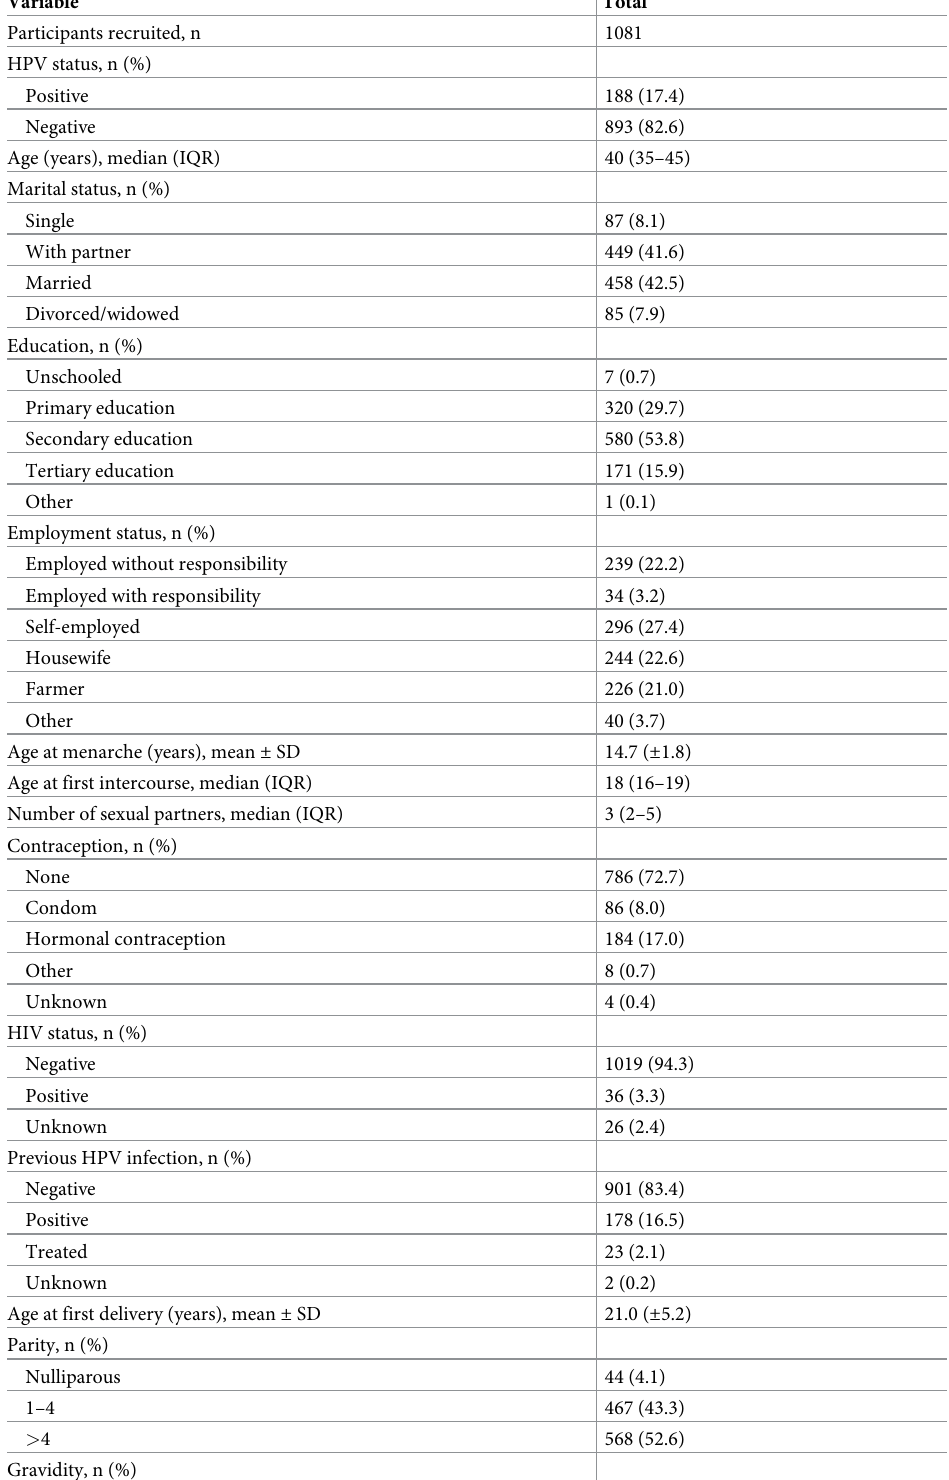
Table 1. Baseline sociodemographic characteristics and reproductive health